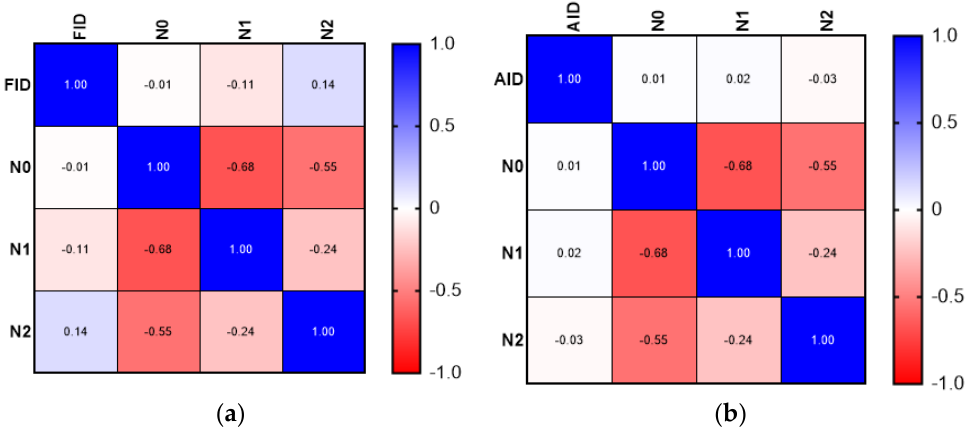
Figure 2. Comparison between FID and AID: ( a ) correlation matrix for FID and N stage; ( b ) correlation matrix for AID and N stage.